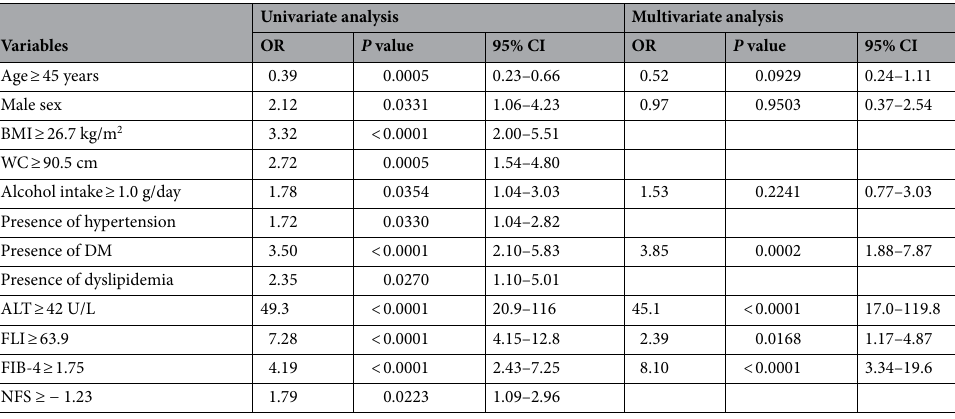
Table 3. Results of the univariate and multivariate analyses: explanatory variables for diagnosing a FAST score ≥ 0.35 in MAFLD patients. ALT: alanine aminotransferase; AST: aspartate aminotransferase; BMI: body mass index; DM: diabetes mellitus; FAST: FibroScan-aspartate aminotransferase; FLI: Fatty liver index; FIB-4: fibrosis-4; GGT: gamma-glutamyltransferase; HDL: high-density lipoprotein; MAFLD: metabolic dysfunction- associated fatty liver disease; NFS: NAFLD fibrosis score; WC: waist